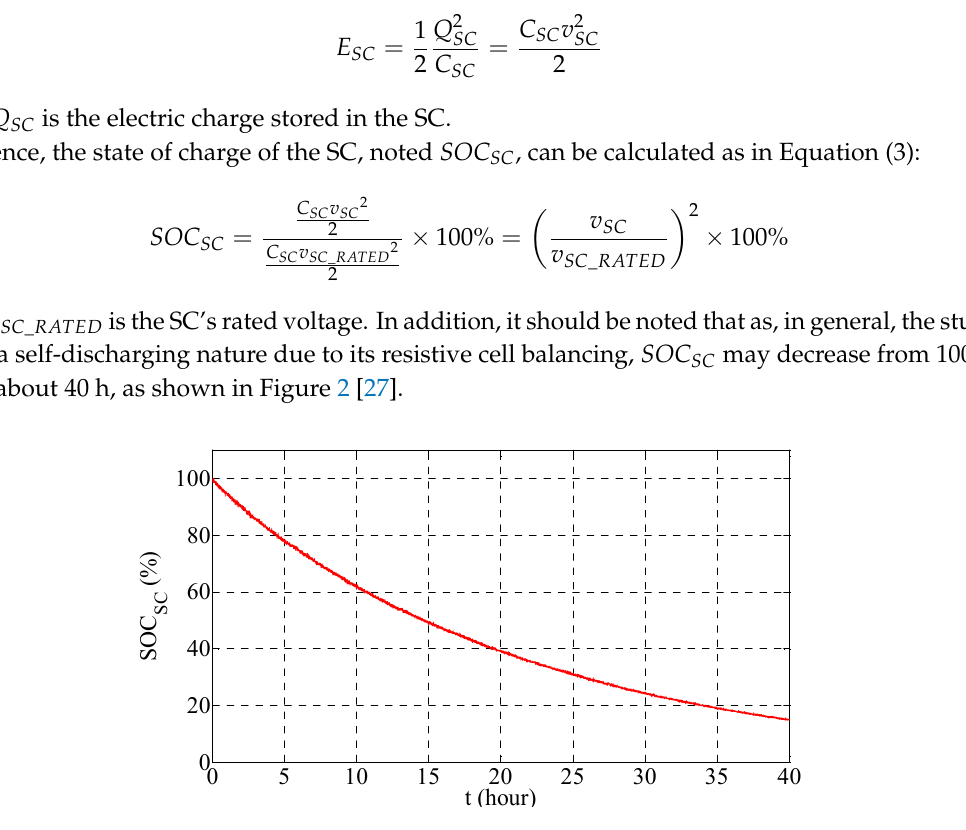
SOC during supercapacitor (SC) self-discharging, as in Reference [27]. Figure 2. Evolution of Figure 2. Evolution of SOC SC during supercapacitor (SC) self-discharging, as in Reference SC